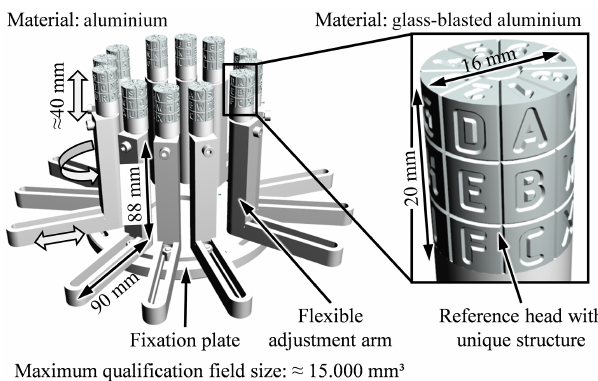
Figure 6. Flexible reference artefact adapted on sheet-bulk metal- formed